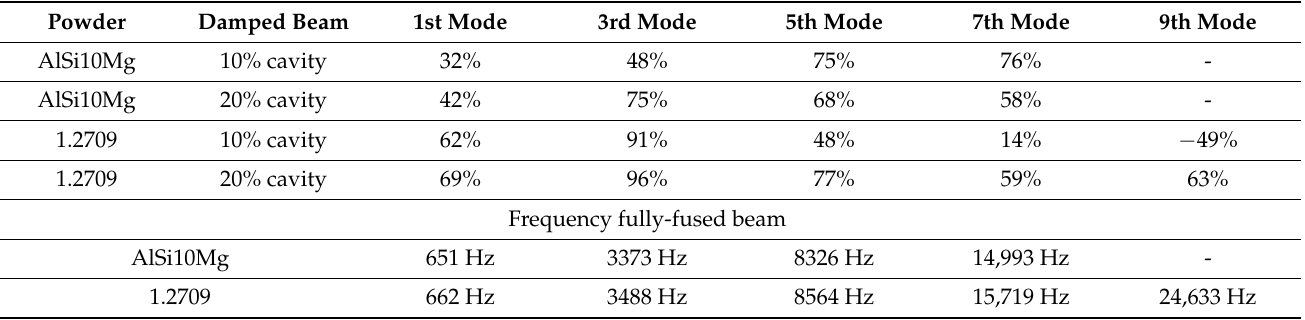
Table 3. Amplitude reduction of the FRF and natural frequencies related to Figure